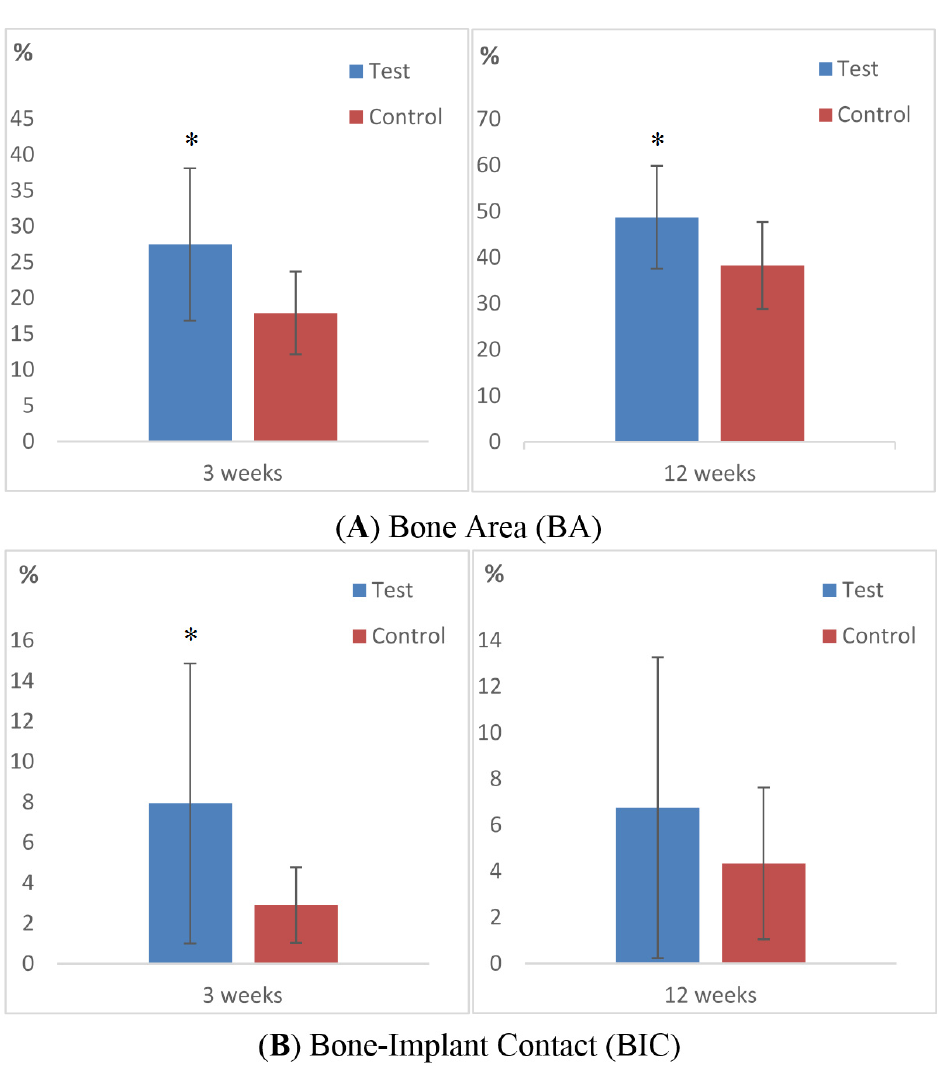
Figure 7. Bar graphs displaying the percentage of ( A ) bone area (BA) and ( B ) bone-to-implant contact (BIC) for test and control after 3 and 12 weeks of healing. Data are presented as mean with standard deviation. Mann Whitney U test was used for testing level of significance. (*, p ≤